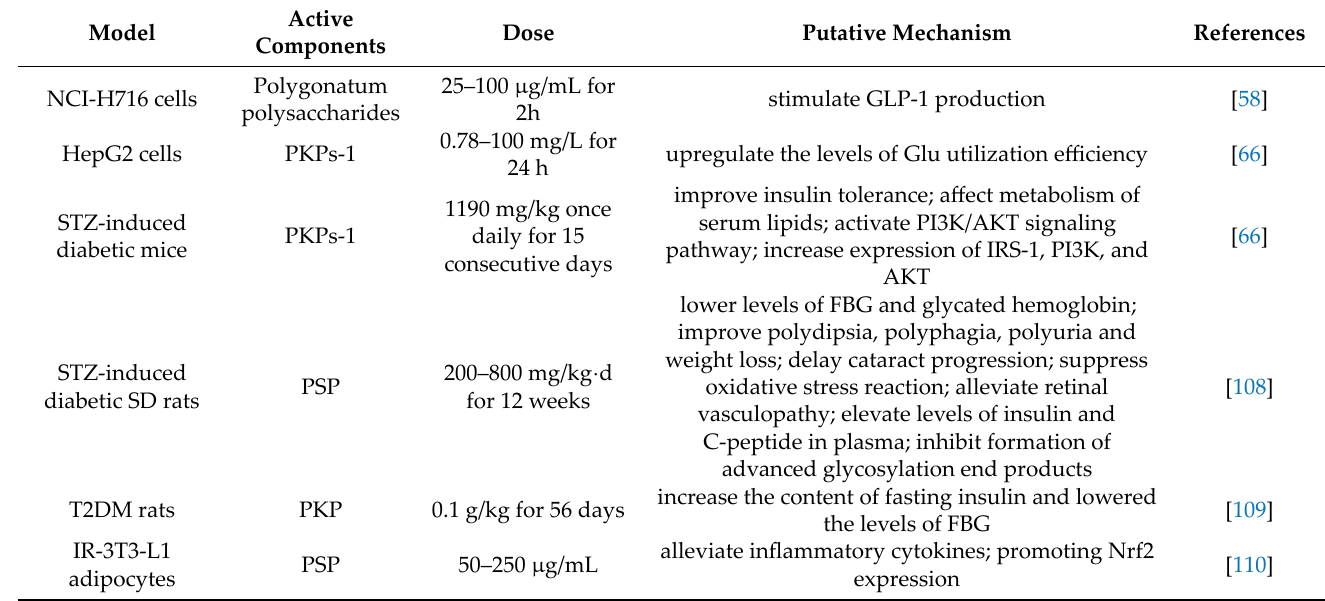
Table 2. Metabolic regulation mechanism of Polygonati Rhizoma